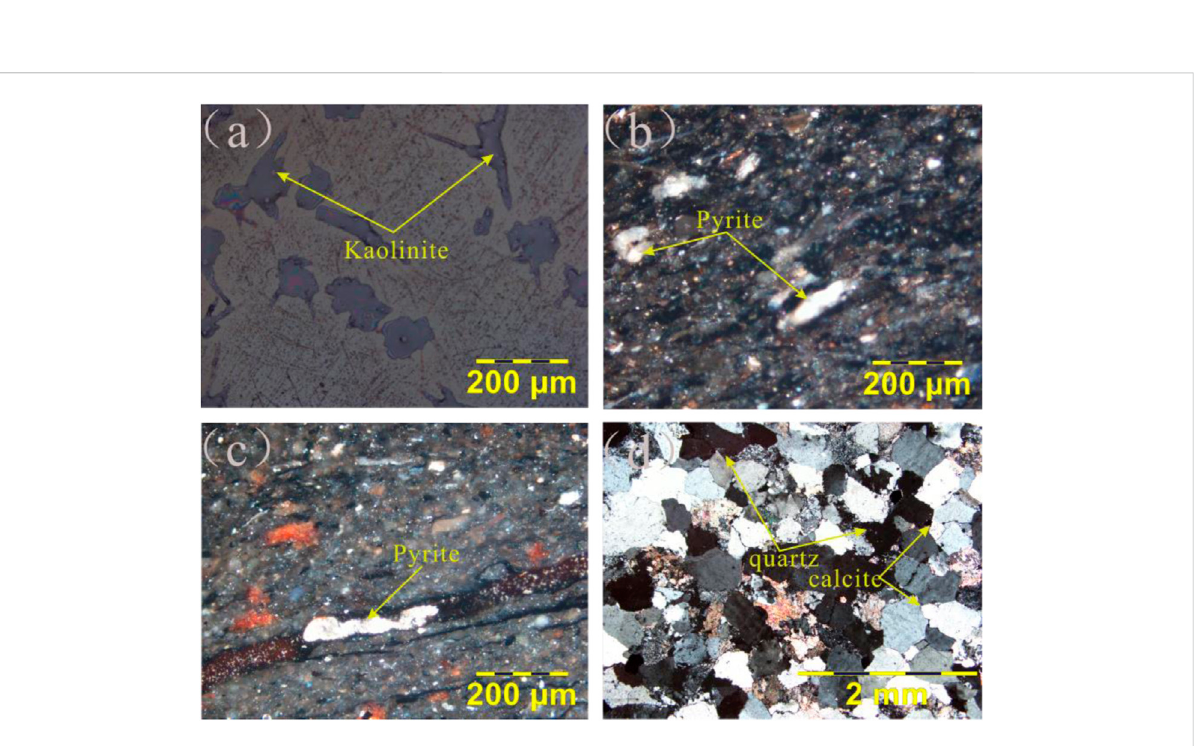
FIGURE 3 Mineral composition of coals in the Shanxi Formation under light microscope. (The labels indicate the names of the minerals contained, (A) Kaolinite, (B) Pyrite, (C) Pyrite, (D) quartz and calcite).